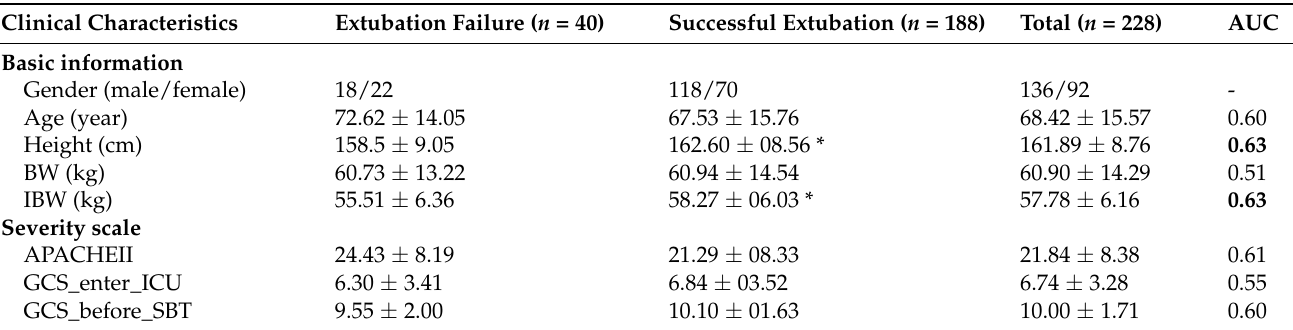
Table 4. Characteristics of the final sample of 228